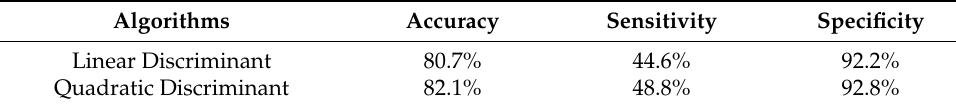
Table A3. Detailed classification performance of discriminant analysis classifiers.